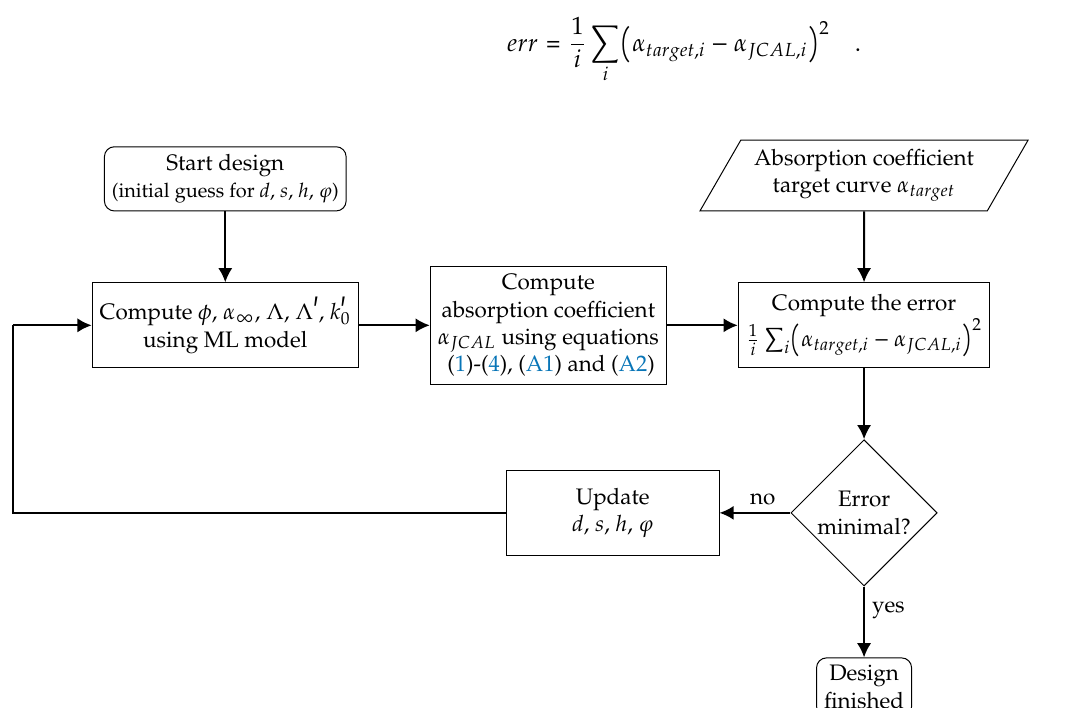
Figure 15. Flow chart of the inverse absorber design process (Step 6 from the flowchart in Figure 1). Based on an initial guess of the design parameters, the corresponding Biot parameters and the resulting absorption coefficient is computed. Based on the given error measure with respect to the target, the design parameters are updated until convergence is